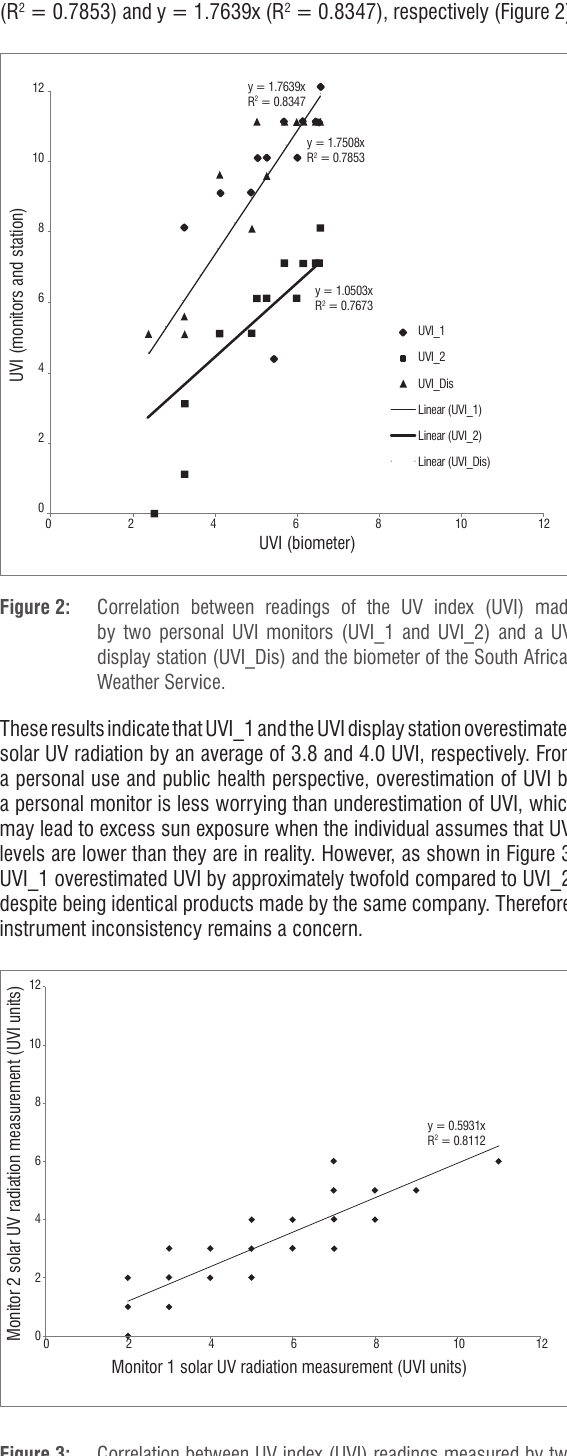
Figure 3: Correlation between UV index (UVI) readings measured by two personal UVI monitors on 18 days in May